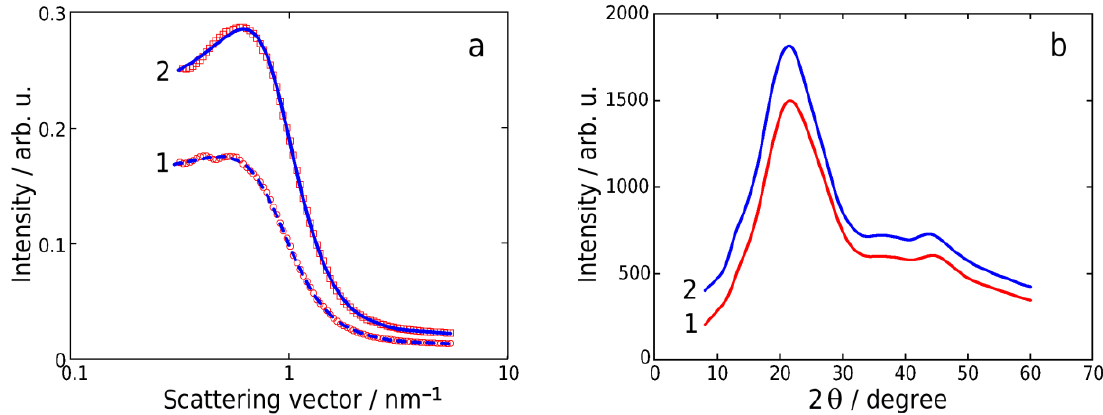
Figure 7. Small-angle ( a ) and wide-angle ( b ) scattering patterns of PUI-530 (1) and PUI-2000 (2) samples.